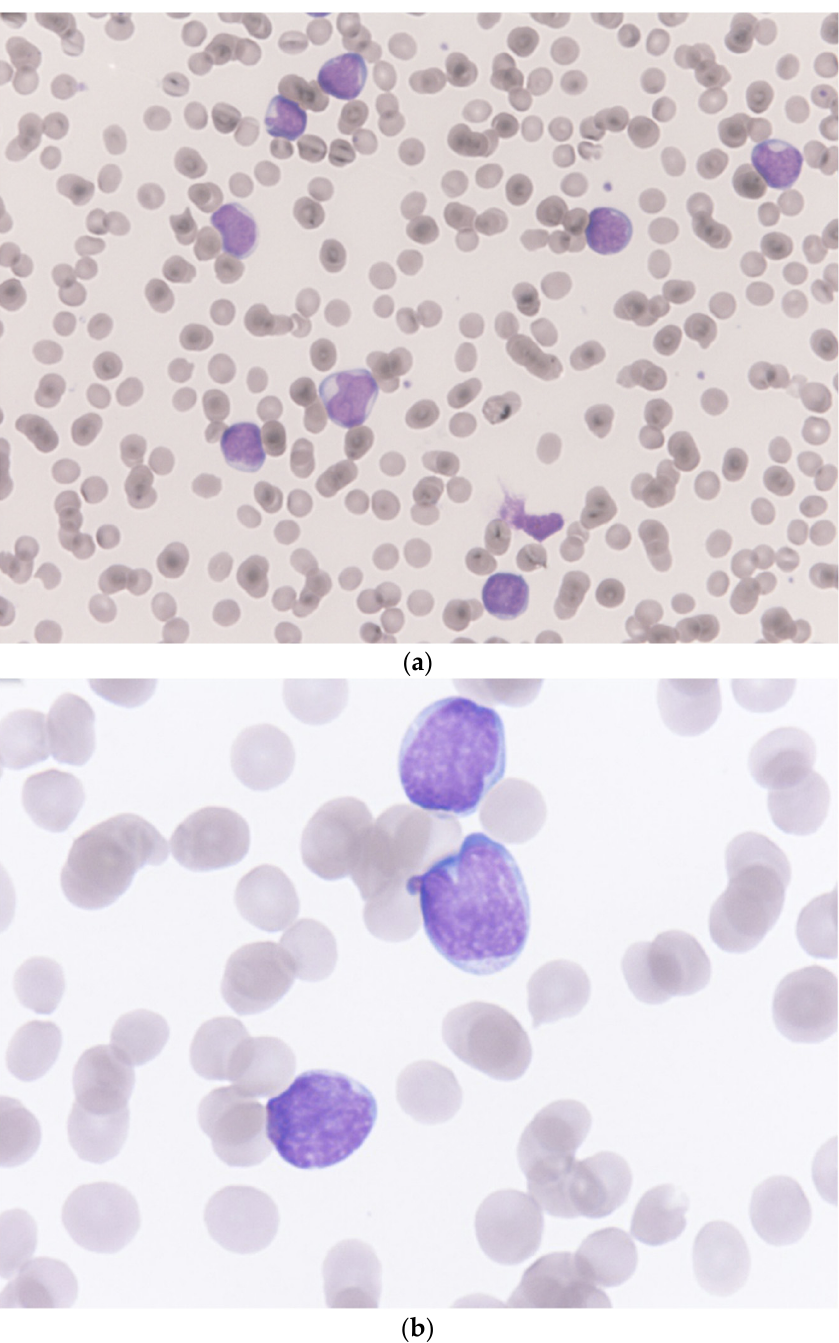
Figure 1. Microscopic pictures of a Giemsa–Wright stained peripheral blood smear from the patient. ( a ) almost all the white blood cells on the visual field were blasts (Magnification 400 × ). ( b ) these large cells with irregular/clefting nuclei, coarse, clumped chromatin, and occasional nucleoli, and high nuclear-to-cytoplasmic ratio indicated acute lymphoblastic leukemia (Magni fi cation 1000×).